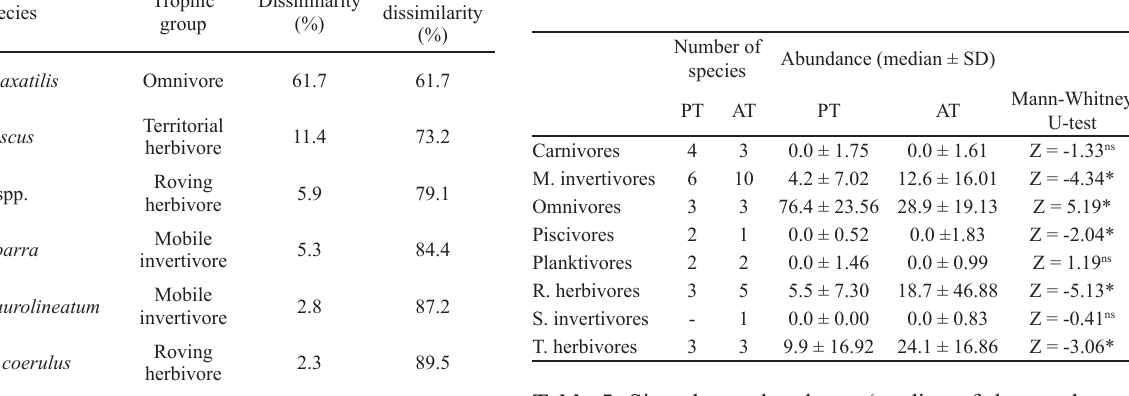
Table 5. Size classe abundance (median of the number of individuals ± SD) per census within the two periods, with the presence of tourists (PT) and absence of tourists